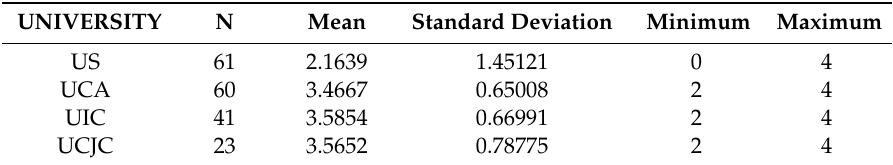
Table 11. Descriptive indices for connection with